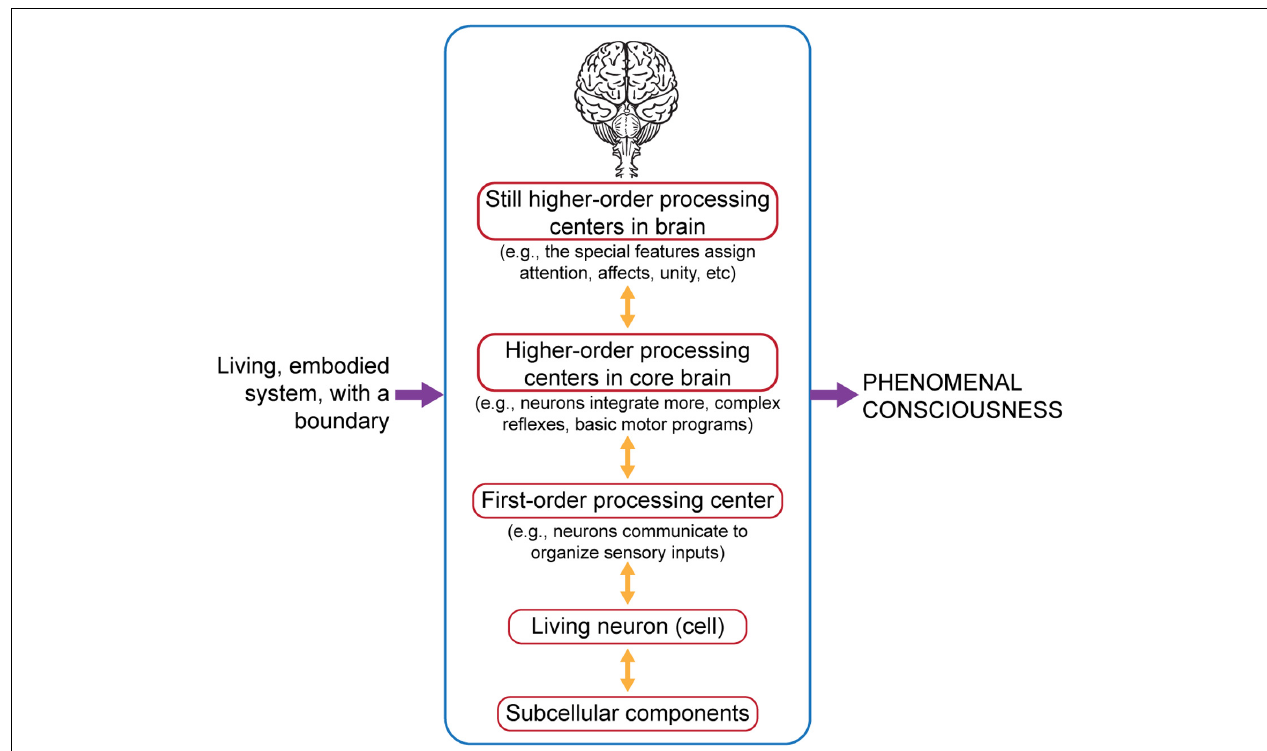
FIGURE 5 | Phenomenal consciousness is an emergent system function that relies on neural hierarchies and also on embodied life ( Table 2 , Level 1 ) and special neurobiological features ( Table 2 , Level 3 ). Our formulation summarizes this: Life + Special neurobiological features → Phenomenal consciousness. Figure © Mount Sinai School of